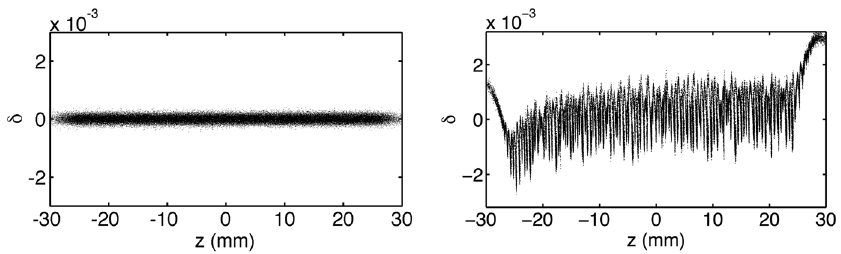
FIG. 4. Longitudinal phase space distributions for the JLEIC CCR: left: initial quiet beam; right: when the beam circulates one turn. Note that z > 0 is for bunch head.